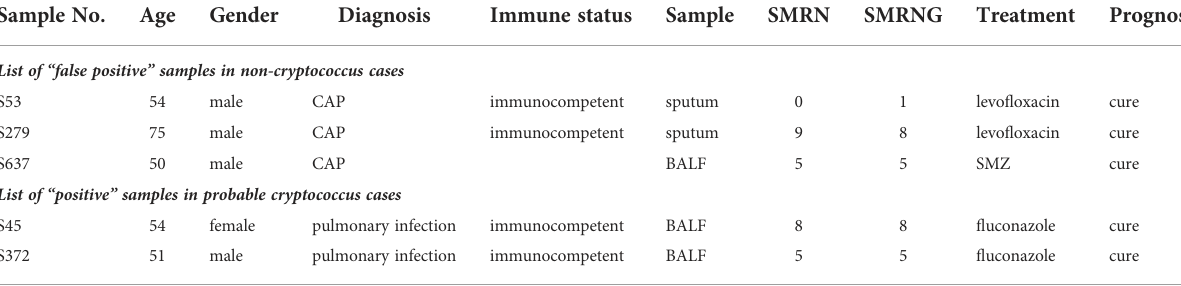
TABLE 2 List of patients with negative traditional detection method and positive mNGS results. Sample